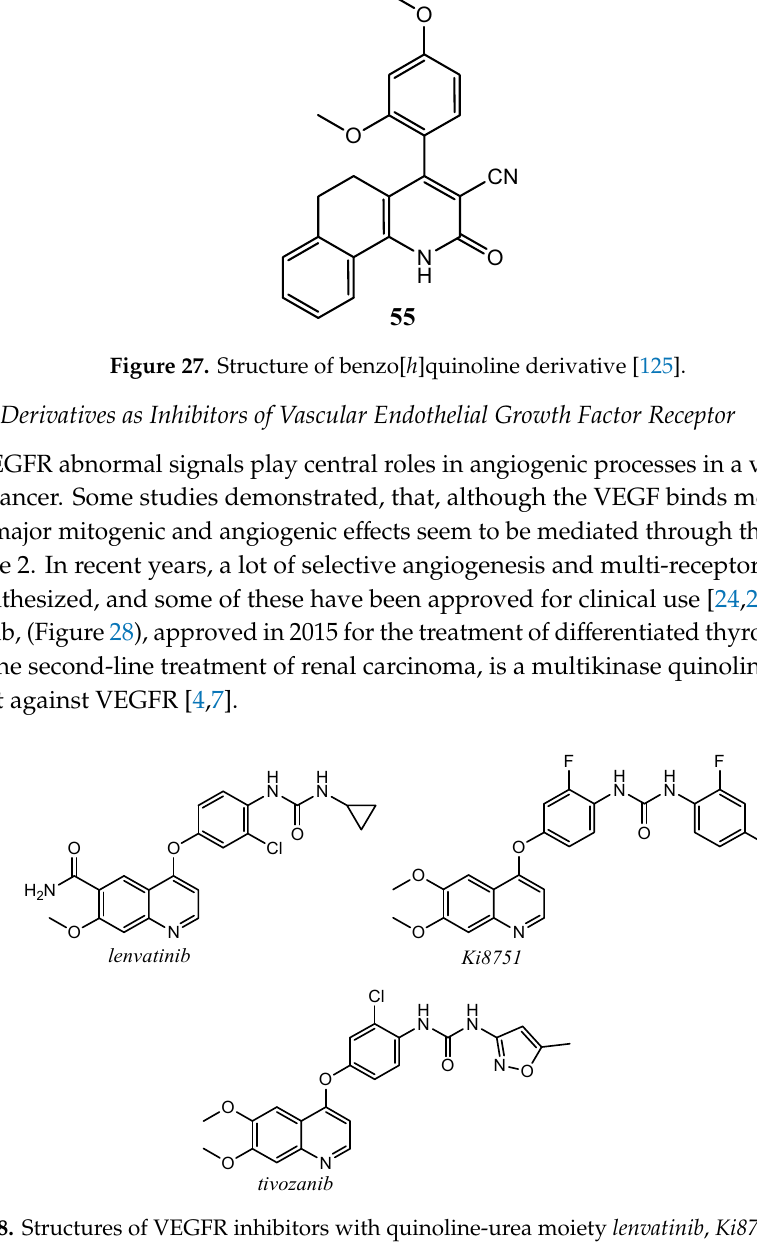
Figure 28. Structures of VEGFR inhibitors with quinoline-urea moiety lenvatinib , Ki8751 , tivozanib .